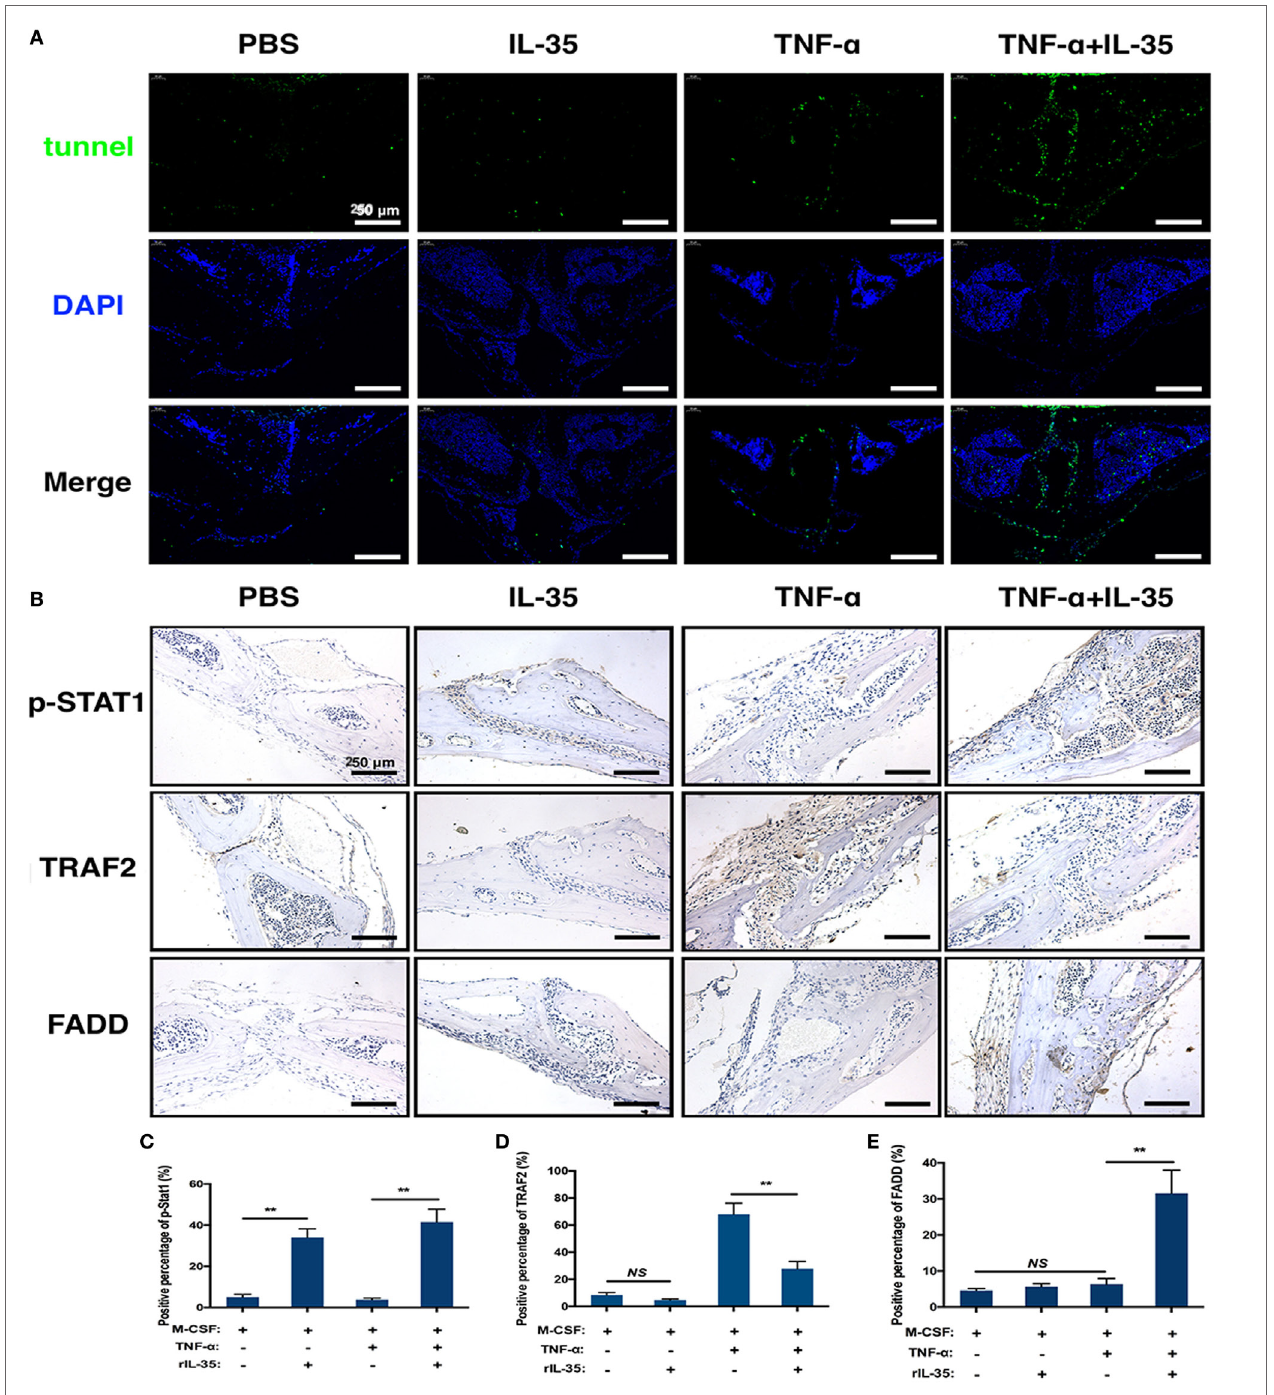
FigUre 7 | Tunel stain and immunohistochemistry analysis. (a) Tunel stain was performed to detect the apoptotic level in the section of calvarias from different groups. (B–e) p-STAT1, TRAF2, and Fas-associated death domain were detected by immunohistochemistry assay and analyzed. * p < 0.05, ** p <